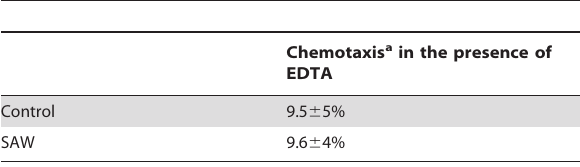
Table 1. SAW enhancement of neutrophil chemotaxis requires